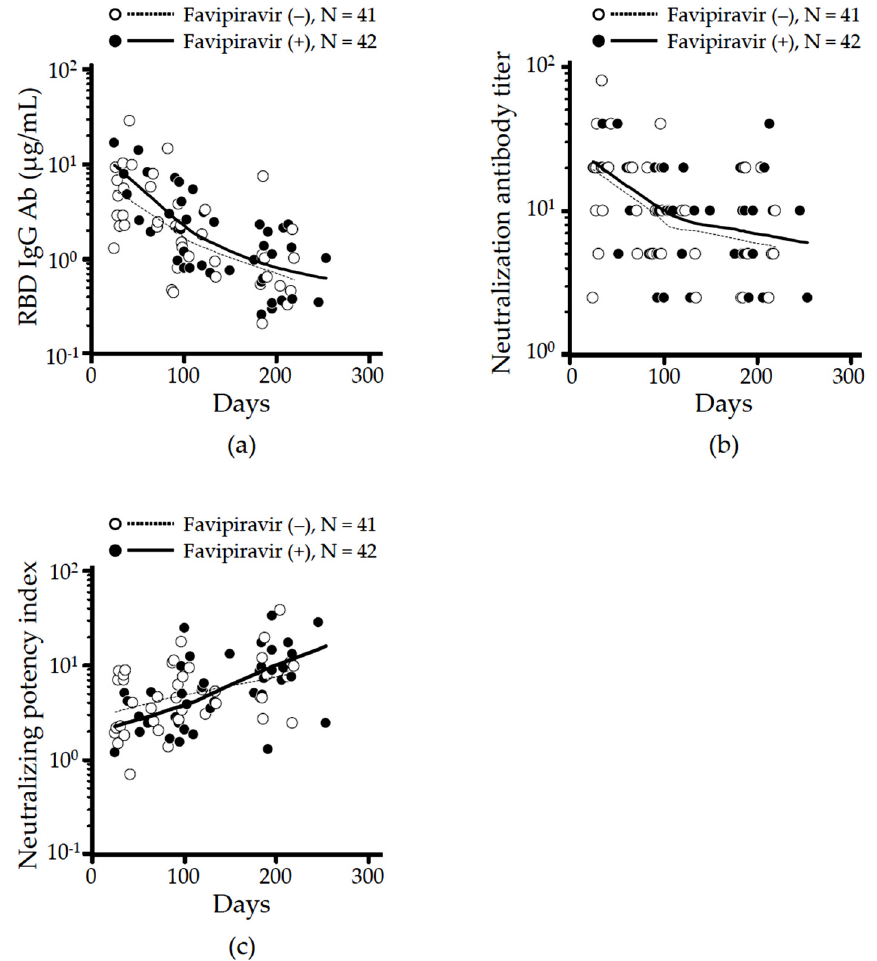
Figure 2. Kinetic analysis of virus-neutralizing antibody production in patients with moderate COVID-19. Longitudinal changes in ( a ) RBD IgG antibody titers, ( b ) neutralizing antibody titers and ( c ) neutralizing potency index in favipiravir treated patients ( • ) versus controls ( ◦ ). Trends were calculated using a locally weighted scatterplot smoothing (LOESS) algorithm and are shown as solid (case) or dotted (control)